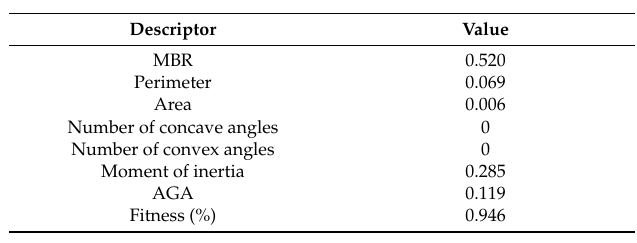
Table 2. Resulting weights from the RCGA for the descriptors shown in Section 3.1. AGA, Arkin Graph Area.